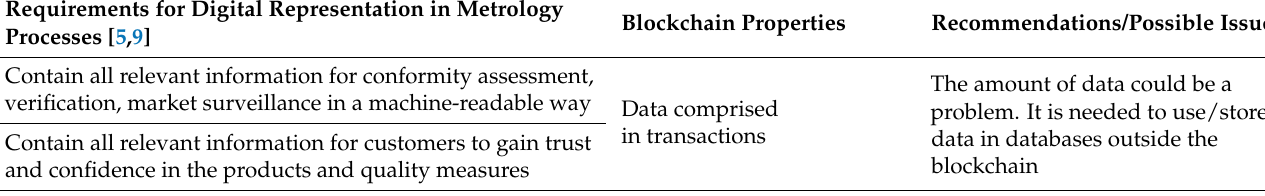
Table 1. Blockchain as an answer for digital representation in metrology